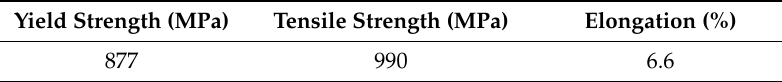
Table 2. Measured mechanical data of DIN